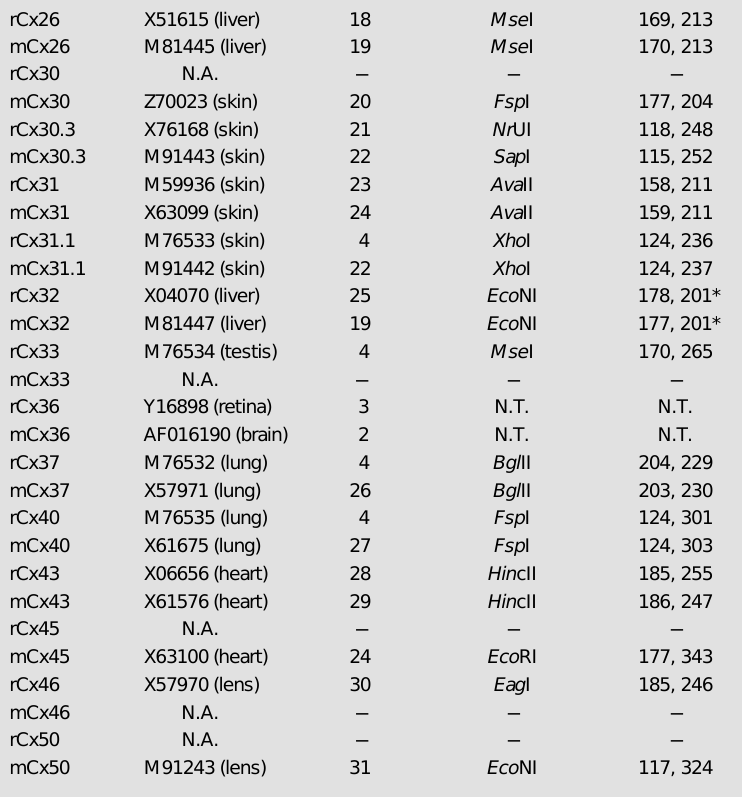
Table 1 - PCR products obtained from the 14 connexins expressed in rodents. Detec- tion of connexin type identity from PCR products. PCR products of cDNA of Cx26, Cx30.3, Cx31, Cx31.1, Cx32, Cx33, Cx37, Cx40, Cx43, Cx45, Cx46 and Cx50. r, Rat; m, mouse. Tissues with high expression, references for molecular cloning and GenBank database accession numbers are listed below. *A cleavage product of 213 bp, corresponding to a canonical site for Eco NI, is routinely found in rat liver. N.A., Not available; N.T., not tested. Connexin (Cx) GenBank access # References Restriction enzymes Products (bp)